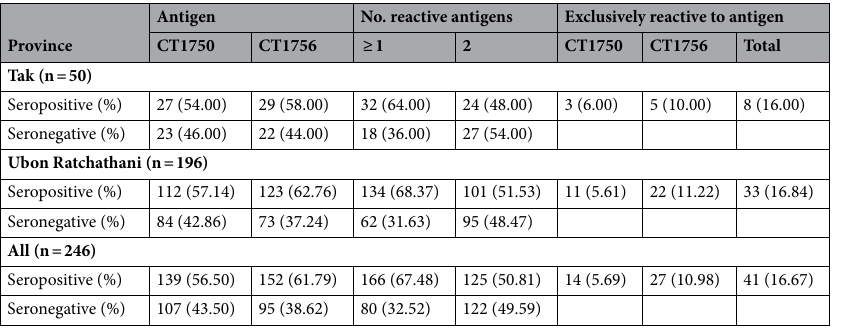
Table 2. Prevalence of IgG antibodies to the C-terminal domain of PvMSP9 among P. vivax -infected Thai patients.